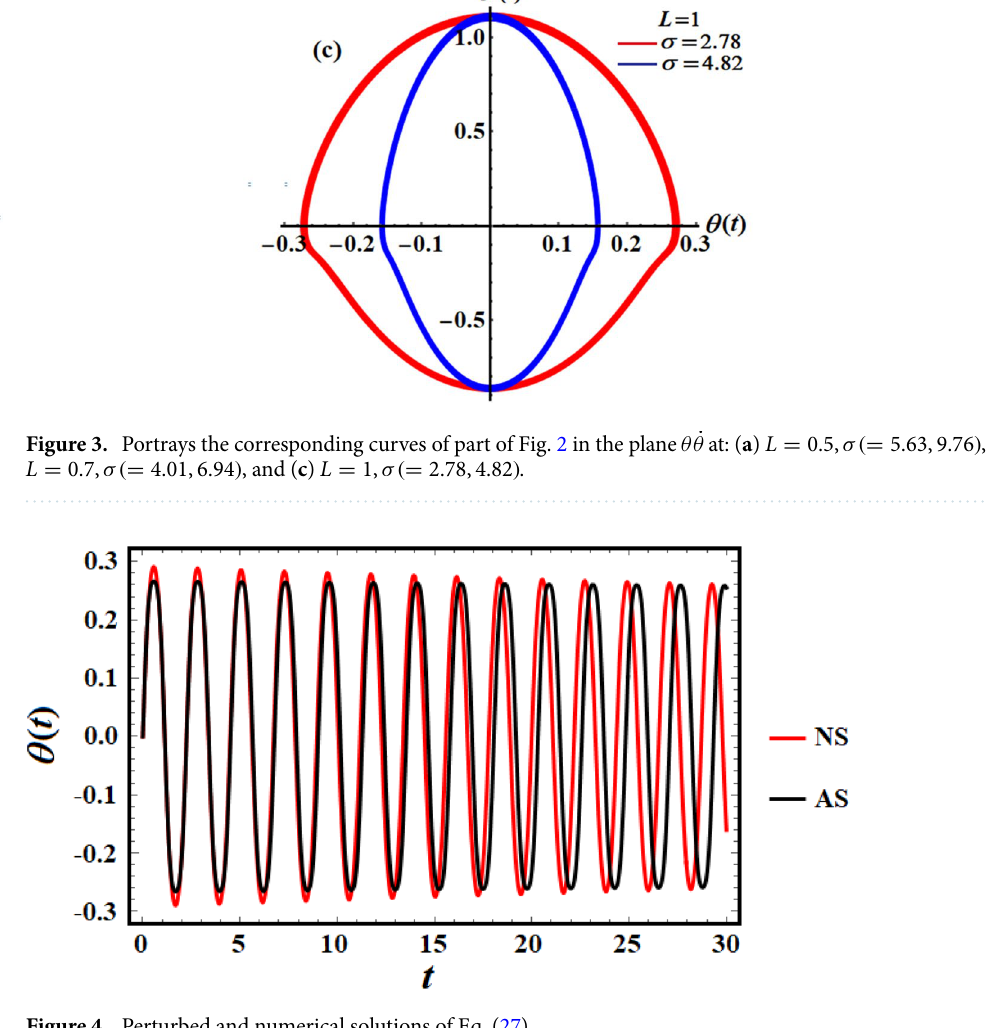
Figure 4. Perturbed and numerical solutions of Eq.